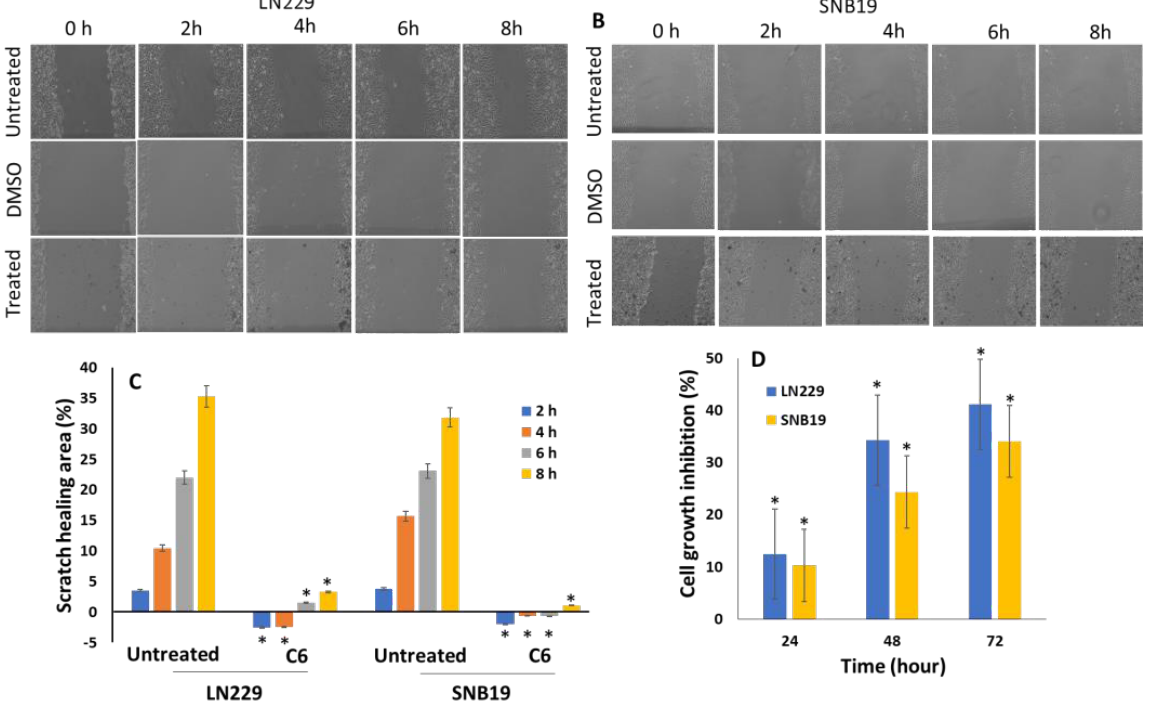
Figure 5. Compound 6 inhibited GBM cell migration and proliferation. Scratch assay was performed in treated GBM cells in an appropriate medium with 2% FBS. Imaging of scratch area for every 2 h up to 8 h. Image shows ( A ) LN229 and ( B ) SNB19 untreated, DMSO-, and compound 6 -treated cells of the scratch assay tracked over time. All images were viewed under a light microscope with a 4X objective (n = 6). ( C ) Quantification of distance migrated after scratching in LN229 and in SNB19 cells. * p < 0.05, treated vs. untreated. ( D ) Percentage of GBM cells treated with the IC 50 concentration for 24 h, 48 h, and 72 h. Datapoints and error bars represent mean ± S.E.M (n = 6). * p < 0.05, treated vs. DMSO control.